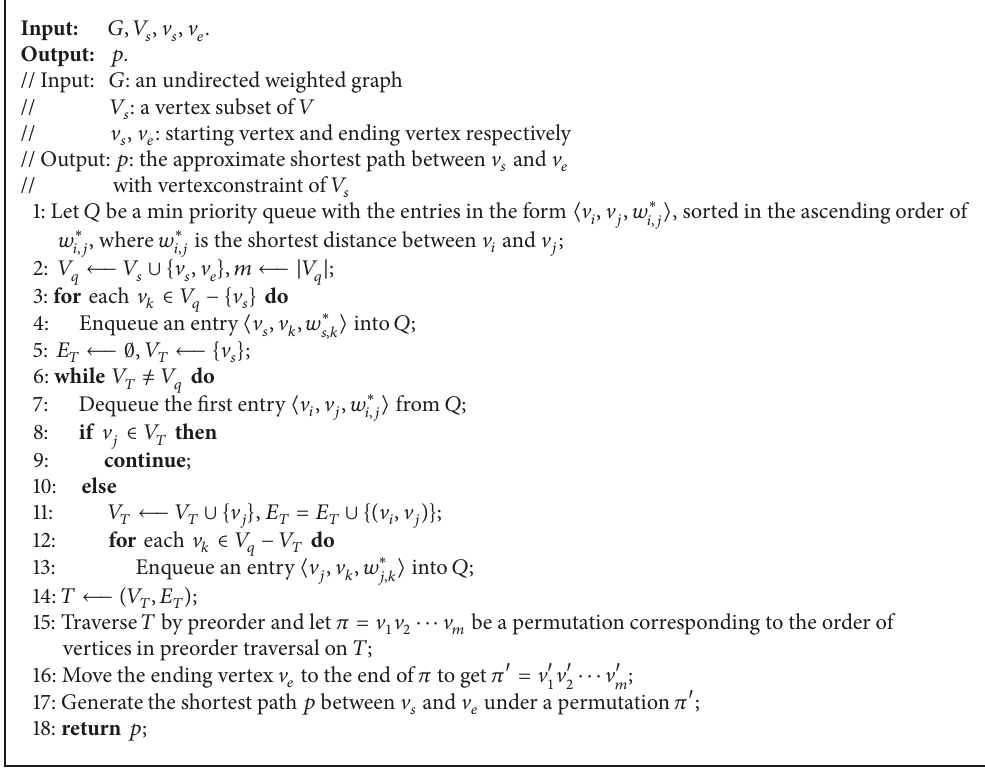
Algorithm 2: Approximate-Path ( 𝐺,𝑉 𝑠 , V 𝑠 , V 𝑒 ).